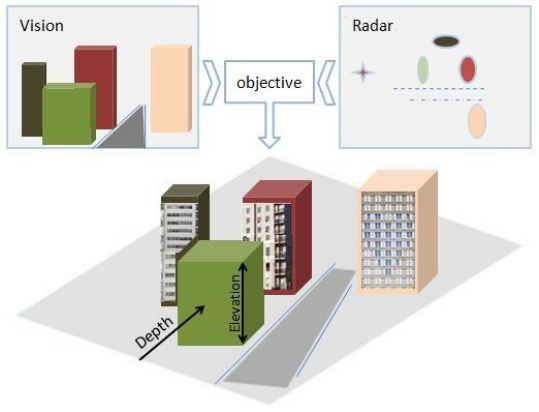
Figure 2. An illustration of the elevation map generation exploiting radar and vision complementarity.